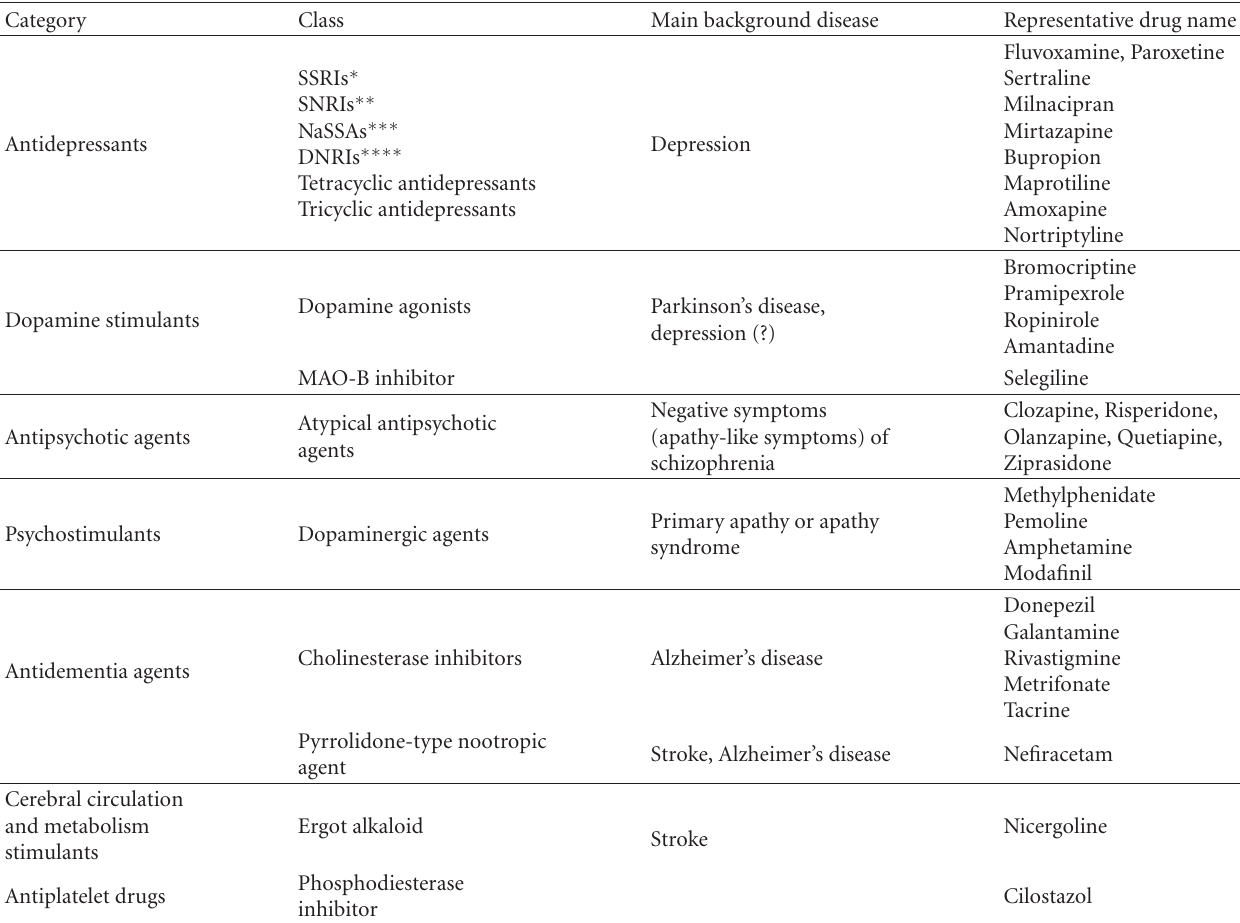
Table 2: Possible medications for